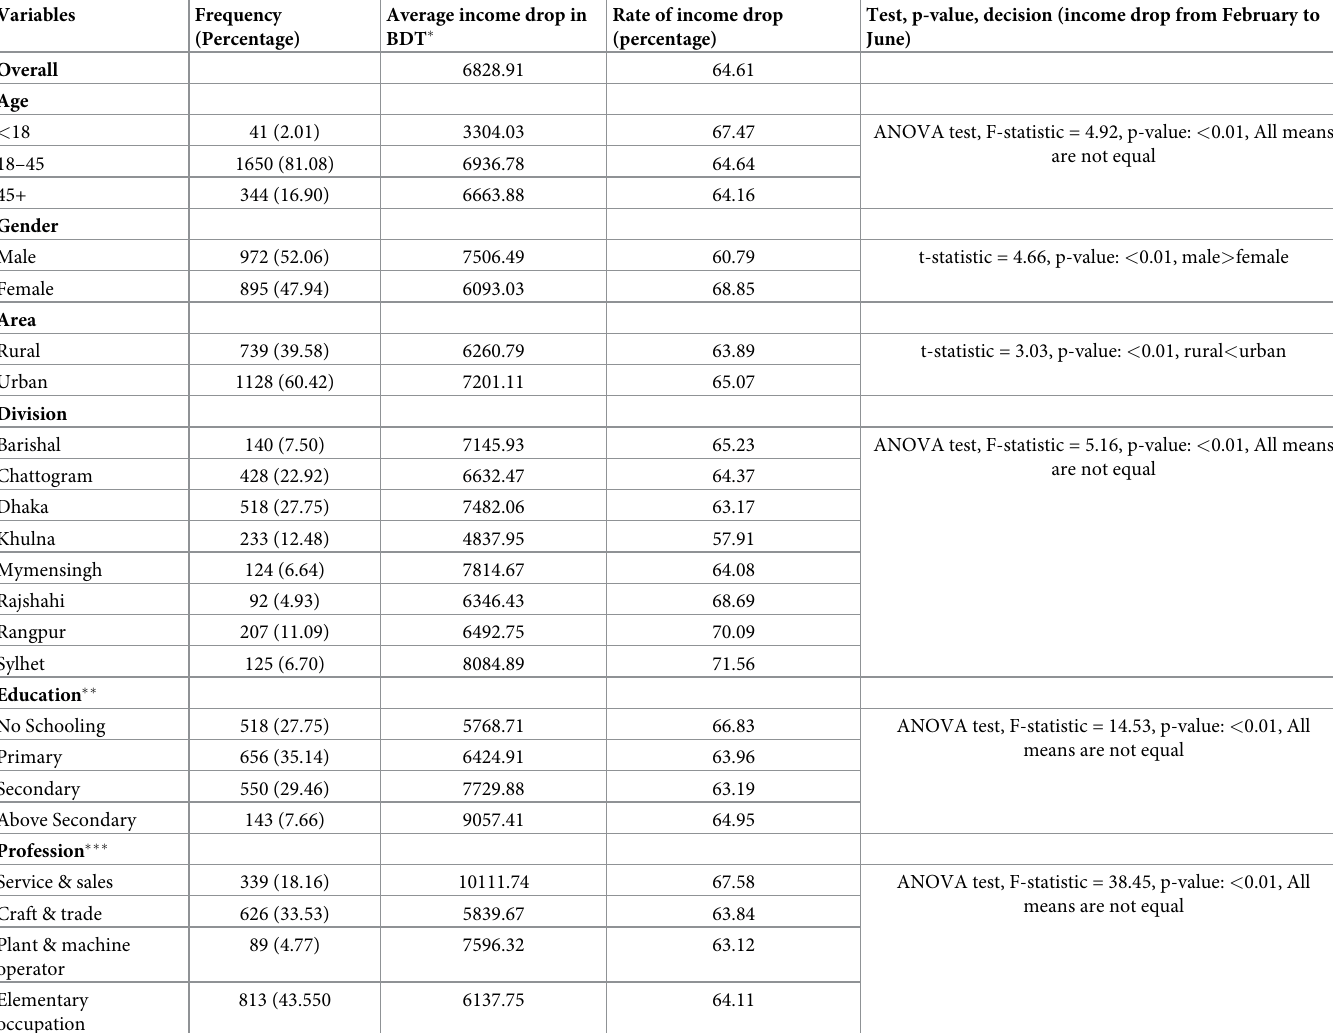
Table 1. Distribution and association of socio-economic characteristics and income